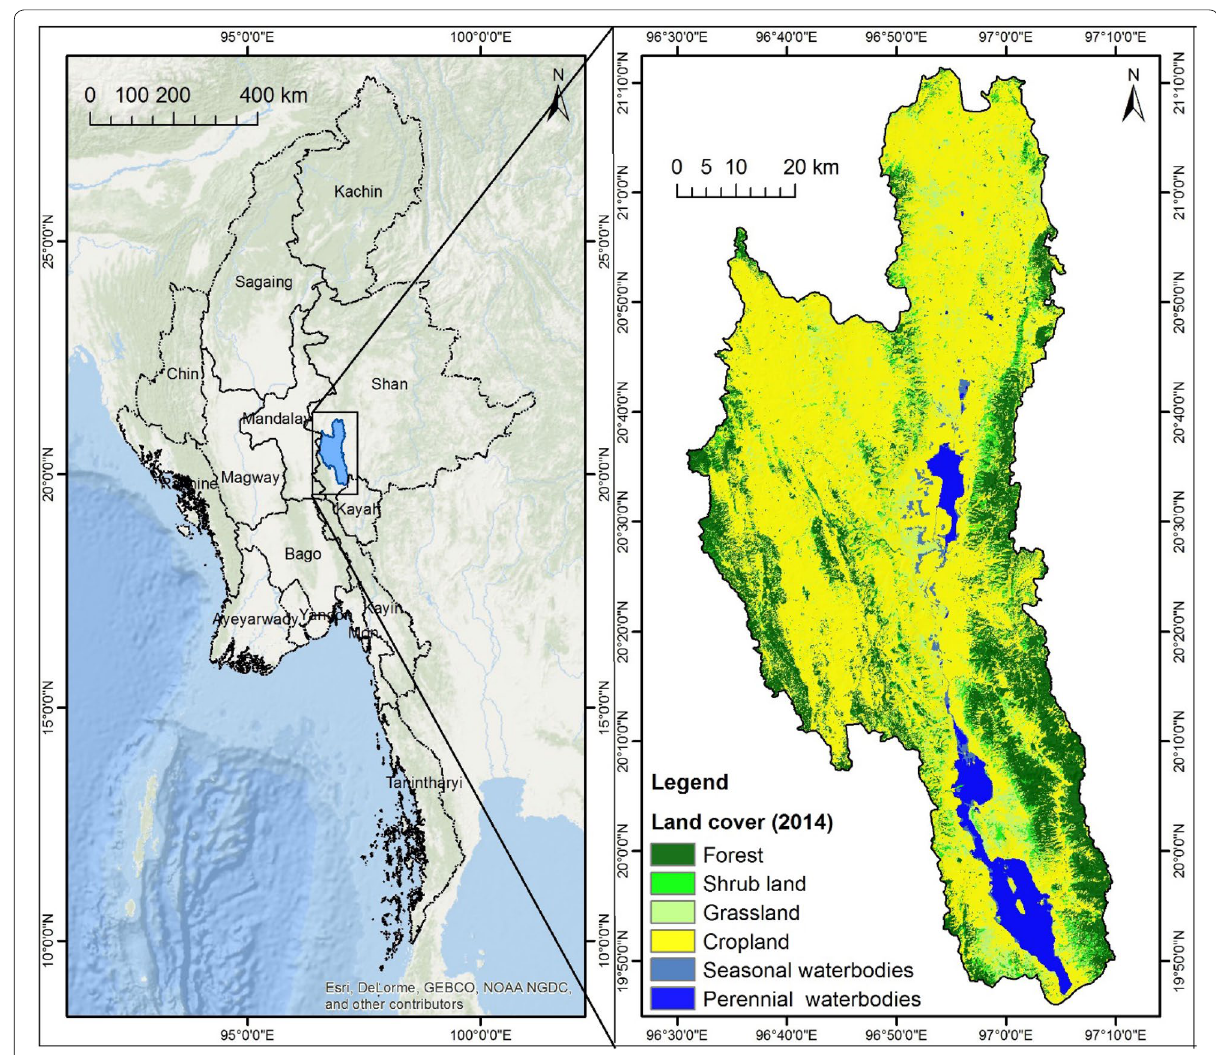
Fig. 1 Map of the study